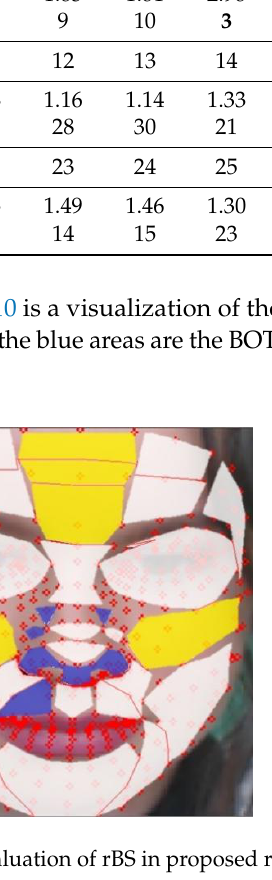
Table 6. The median value of rBS and rBS ranking of regions. Region 0 1